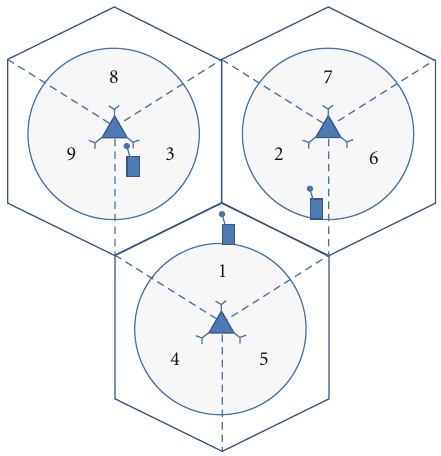
Figure 1: Cellular system showing in-cell and cell-edge users in an interference channel setup.